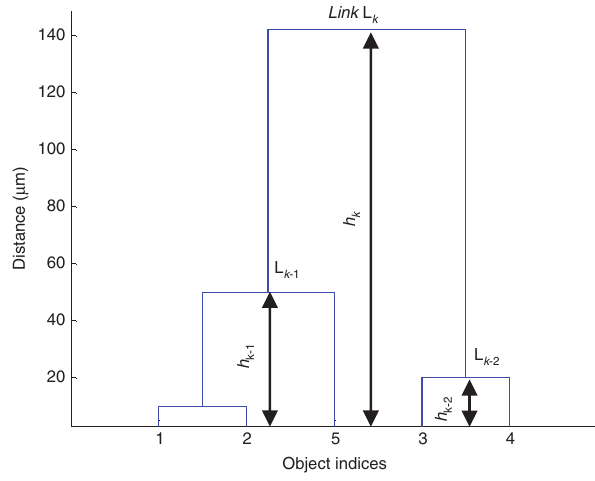
Figure 5: Representation of the height and link along a